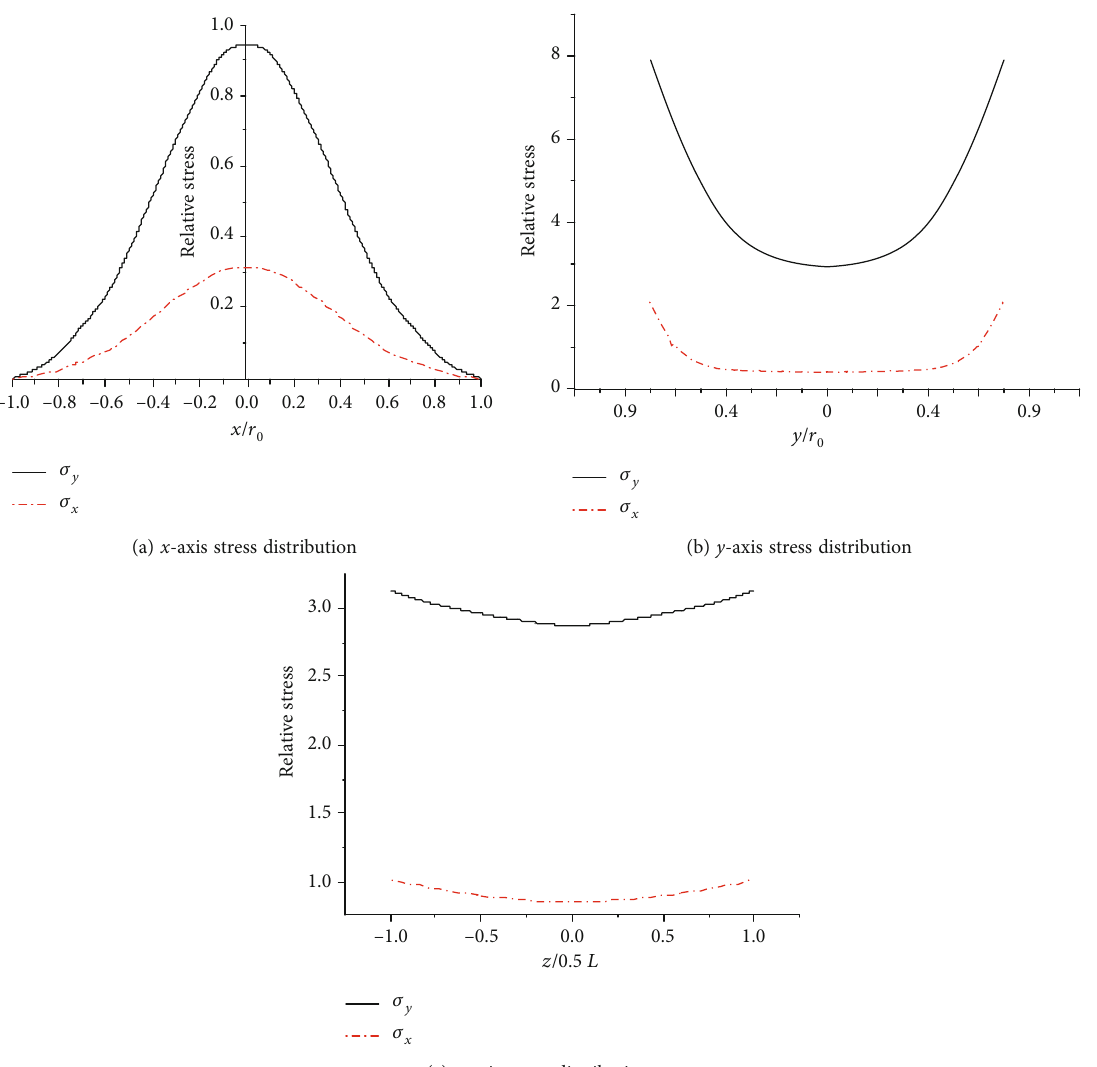
Figure 3: Numerical simulation of three-direction stress distribution of Brazilian disc